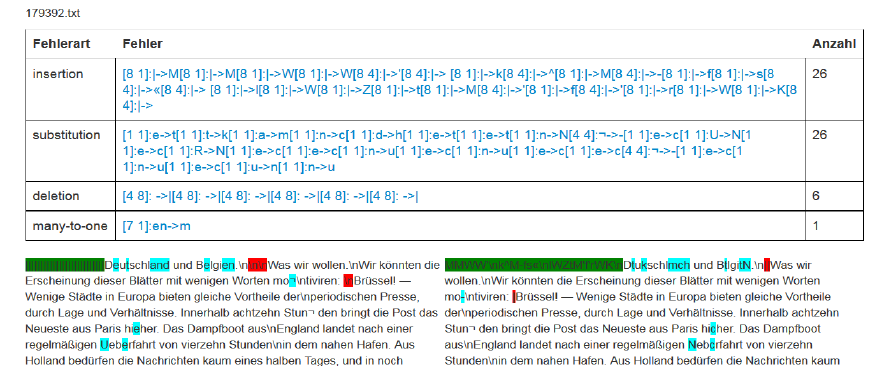
Fig. 5 The software tool ocr-visualizer also generates statistics for the OCR character